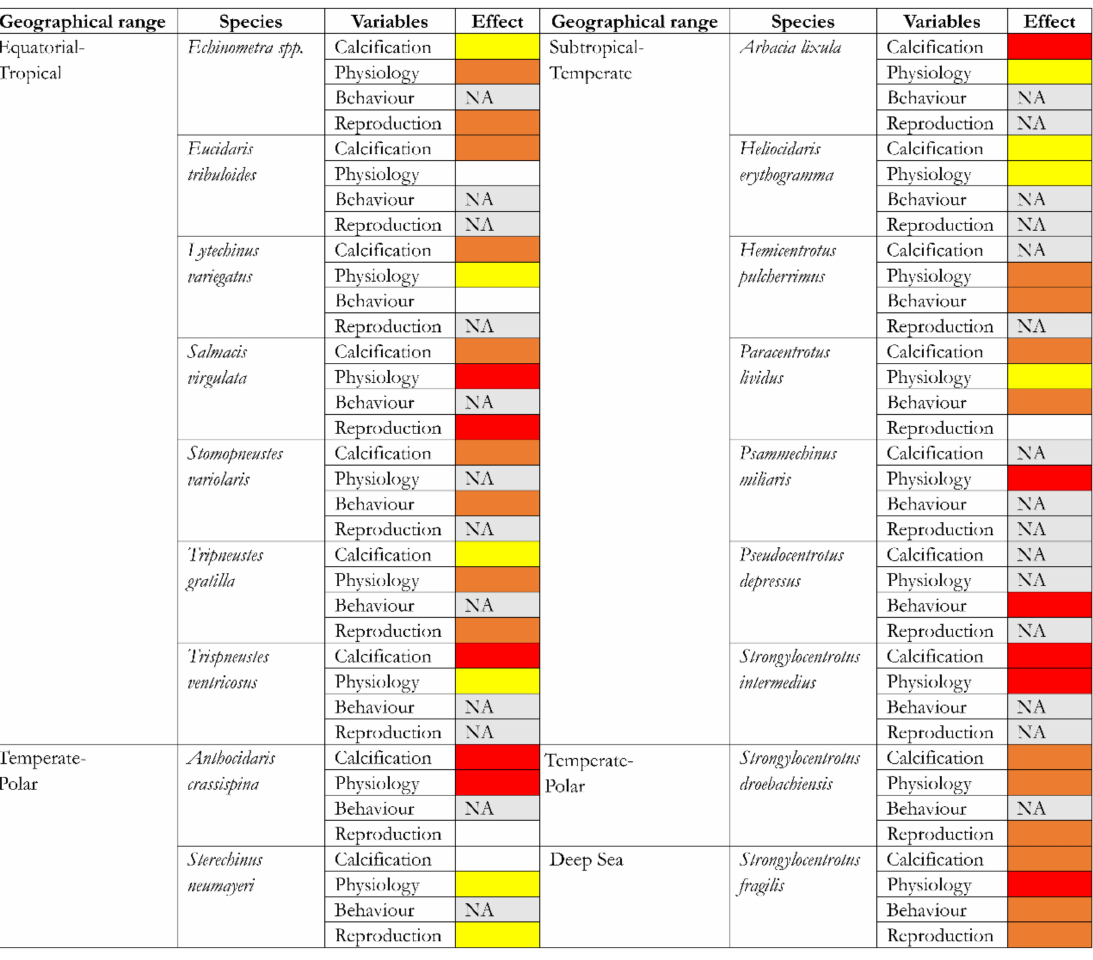
Figure 1. Summary of the effects of seawater acidification on echinoids. For each species and variable considered, colour denotes the percentage of papers showing alterations due to the pH reduction. White: 0–10%; yellow: 10–40%; orange: 40–70%; red: 70–100%; grey: no articles on the